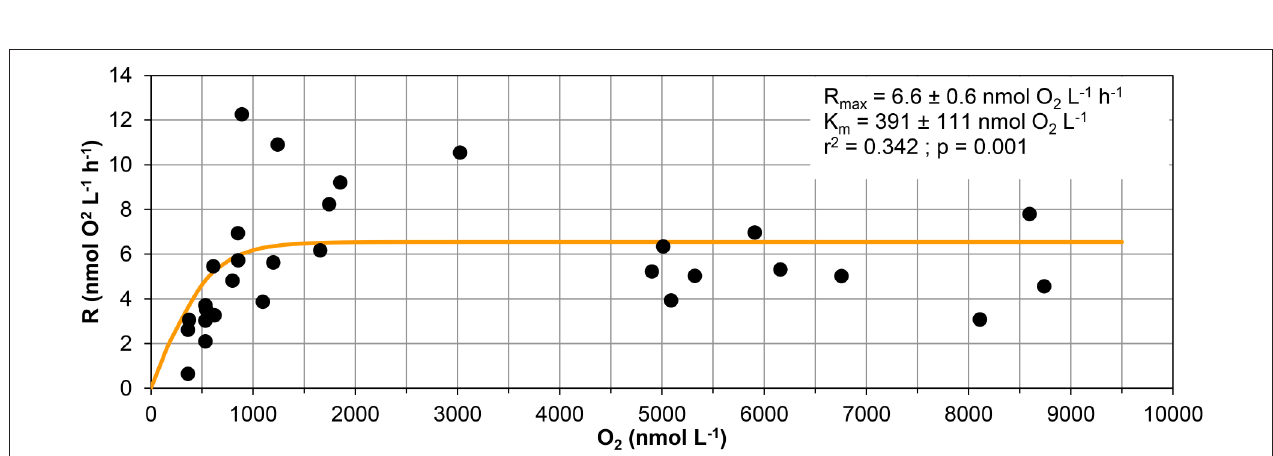
FIGURE 5 | Respiration vs. oxygen concentration. Respiration data measured in samples collected at 70m at station GD-1 from 4 days (19th, 20th , and 30th of January and 1st of February 2015) used to calculate the respiratory kinetic parameters ( R max and K m ). Data are initial respiration rates ( R 0 ) and average O 2 concentration during the corresponding